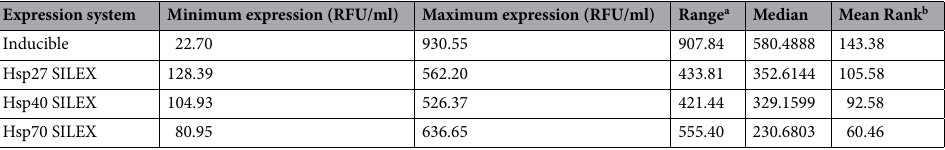
Table 1. Descriptive analysis of EGFP Expression in SILEX and inducible systems. a The difference between the lowest and highest values in each expression system. b Ranking all the values from low to high, and then compared the means ranks.